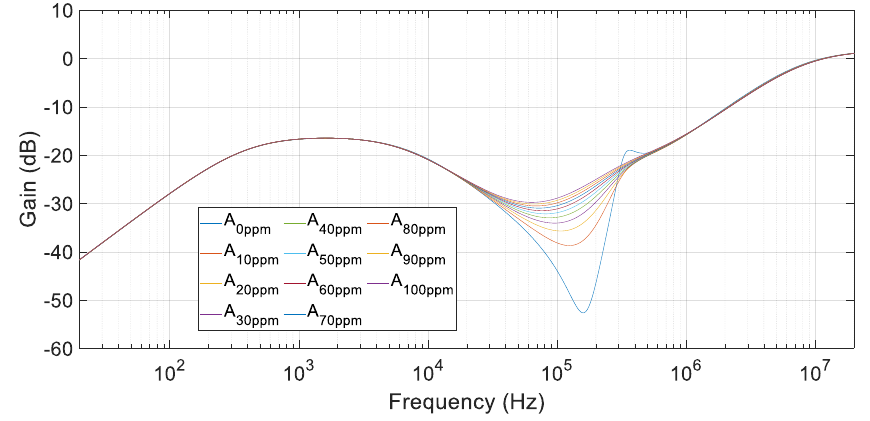
Figure 7. Simulation results for different salt in water concentrations, from 0 ppm up to 100 ppm.